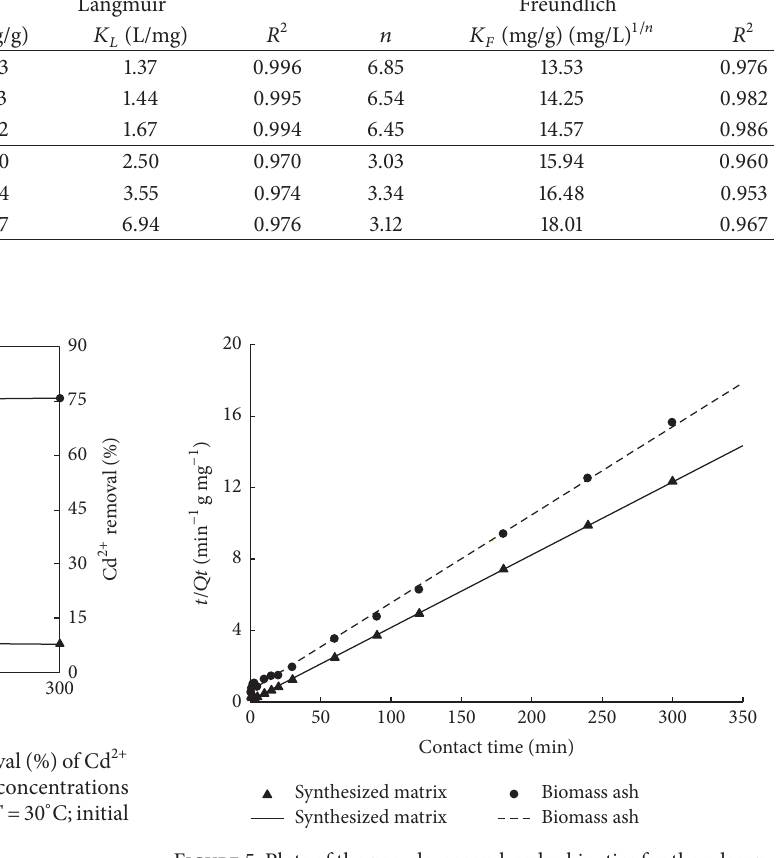
Figure 5: Plots of the pseudo-second-order kinetics for the adsorp- tions of Cd 2+ on biomass ash and the synthesized matrix (initial concentrations of Cd 2+ , 100mg/L; biomass ash concentration, 2 g/L; 𝑇 = 30 ∘ C; pH